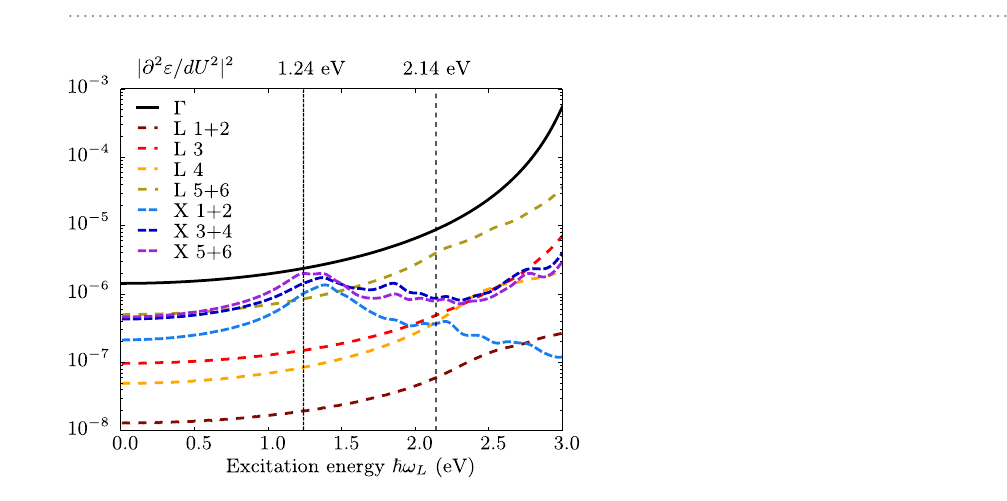
Figure 7. Second derivatives of the IPA dielectric function with respect to the excitation energy for different modes at the Γ , X , and L points. The notation “ q m” represents the m th branch of a q-point ( Γ , X , or L ), while “q m + n ” represents the sum of the corresponding derivatives of the degenerate branches m and n at this point. The electronic transition thresholds for X (1.24 eV) and L (2.14 eV) are also